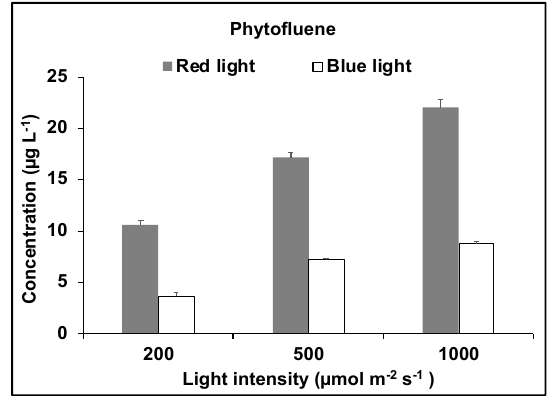
Figure 11. Phytofluene concentration in D. salina under red light or blue light at different light intensities (200, 500 or 1000 µmol·m −2 ·s −1 ) for 48 h.